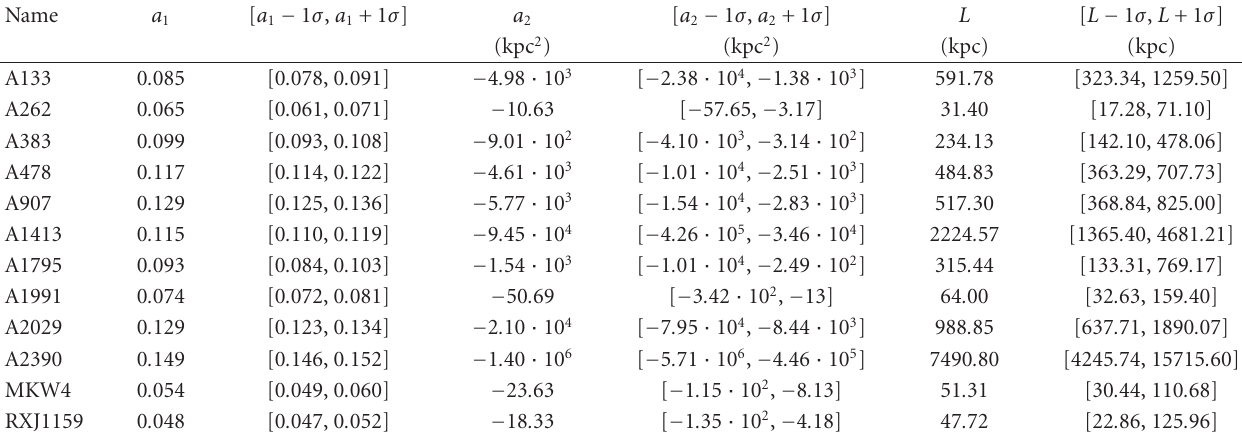
Table 2: Column 1: Cluster name. Column 2: first derivative coe ffi cient, a 1 , of f ( R ) series. Column 3: 1 σ confidence interval for a 1 . Column 4: second derivative coe ffi cient, a 2 , of f ( R ) series. Column 5: 1 σ confidence interval for a 2 . Column 6: characteristic length, L , of the modified gravitational potential, derived from a 1 and a 2 . Column 7: 1 σ confidence interval for L